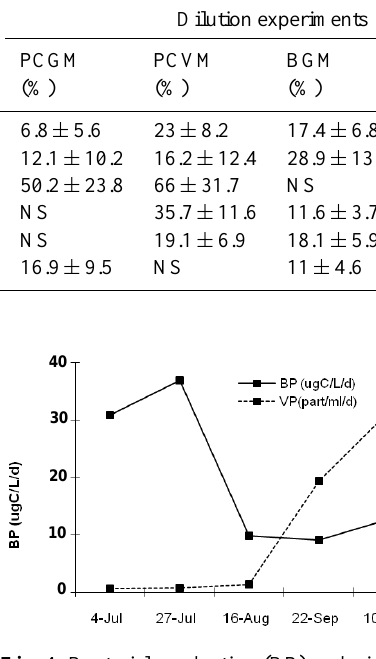
Fig. 4. Bacterial production (BP) and viral production (VP) measured from July to November 2011. 761 762